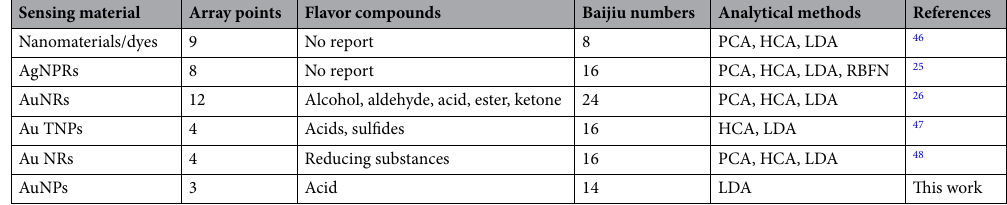
Sensing material Array points Flavor